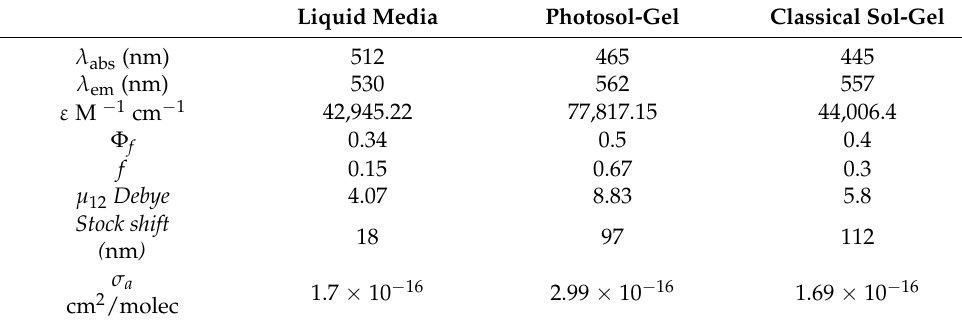
Table 1. Photophysical parameters of DBDMA in different media. Liquid Media Photosol-Gel Classical